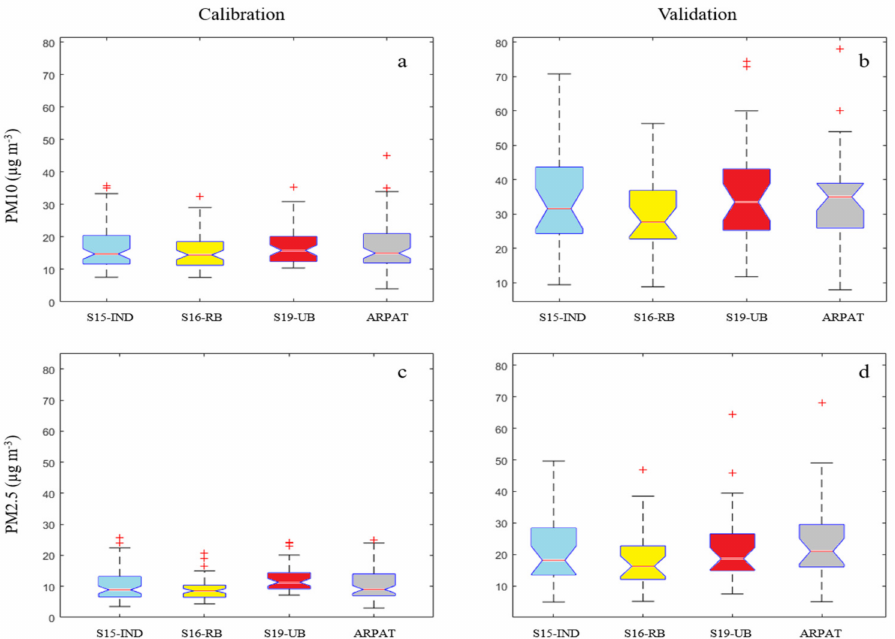
Figure 2. Boxplot of daily averaged PM 10 and PM 2.5 concentrations measured by the AirQino stations as compared to ARPAT daily observations during the periods of field calibration for ( a ) PM 10 and ( c ) PM 2.5 ; field validation for ( b ) PM 10 and ( d ) PM 2.5